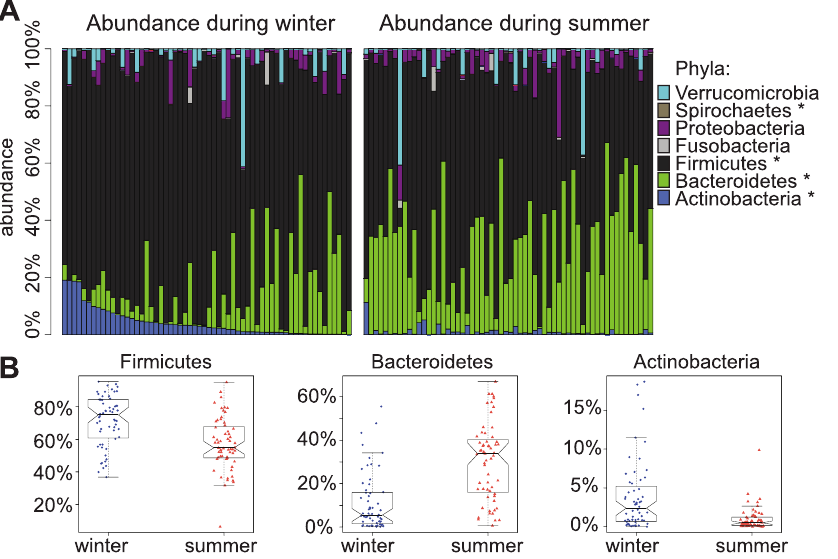
Figure 3. Phylum level taxa abundances differ by season. A) Abundance (y-axis) of the 25 bacterial phyla that were detected (only the most common bacteria are indicated in the legend) by individual (x-axis). Individual’s order along the x-axis is identical in both panels. Phyla that are significantly differentially abundant between seasons (FDR , 0.05) are indicated by an asterisk. B) Examples of three common phyla whose abundances (y-axis) are significantly different across seasons (x-axis): Firmicutes (q-value , 0.002), Bacteroidetes (q-value , 0.002), and Actinobacteria (q-value , 0.002).